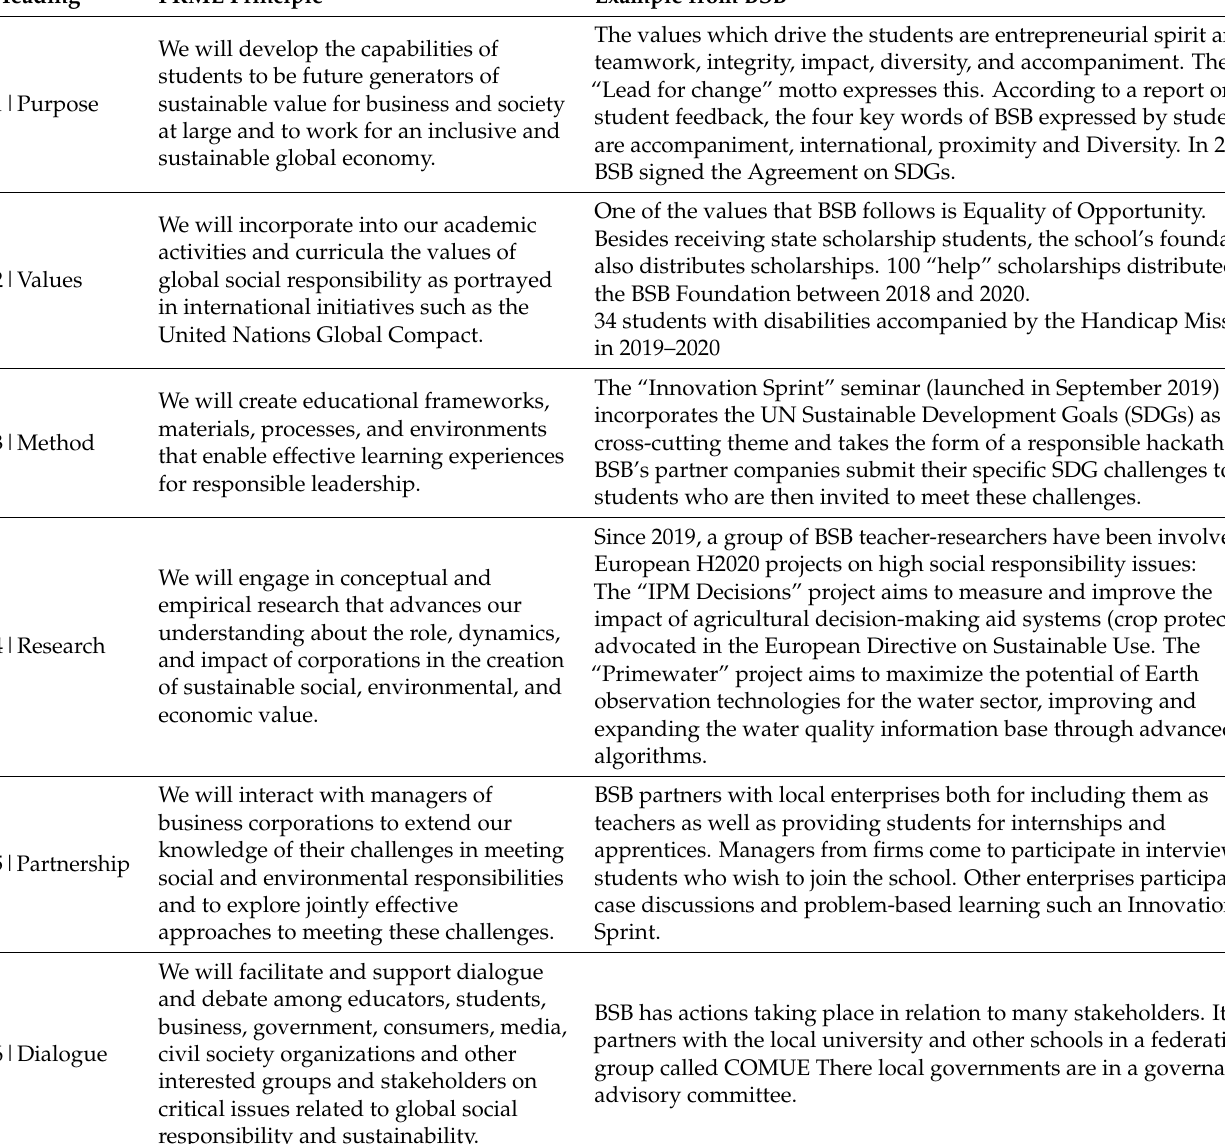
Table 2. How BSB responds to PRME